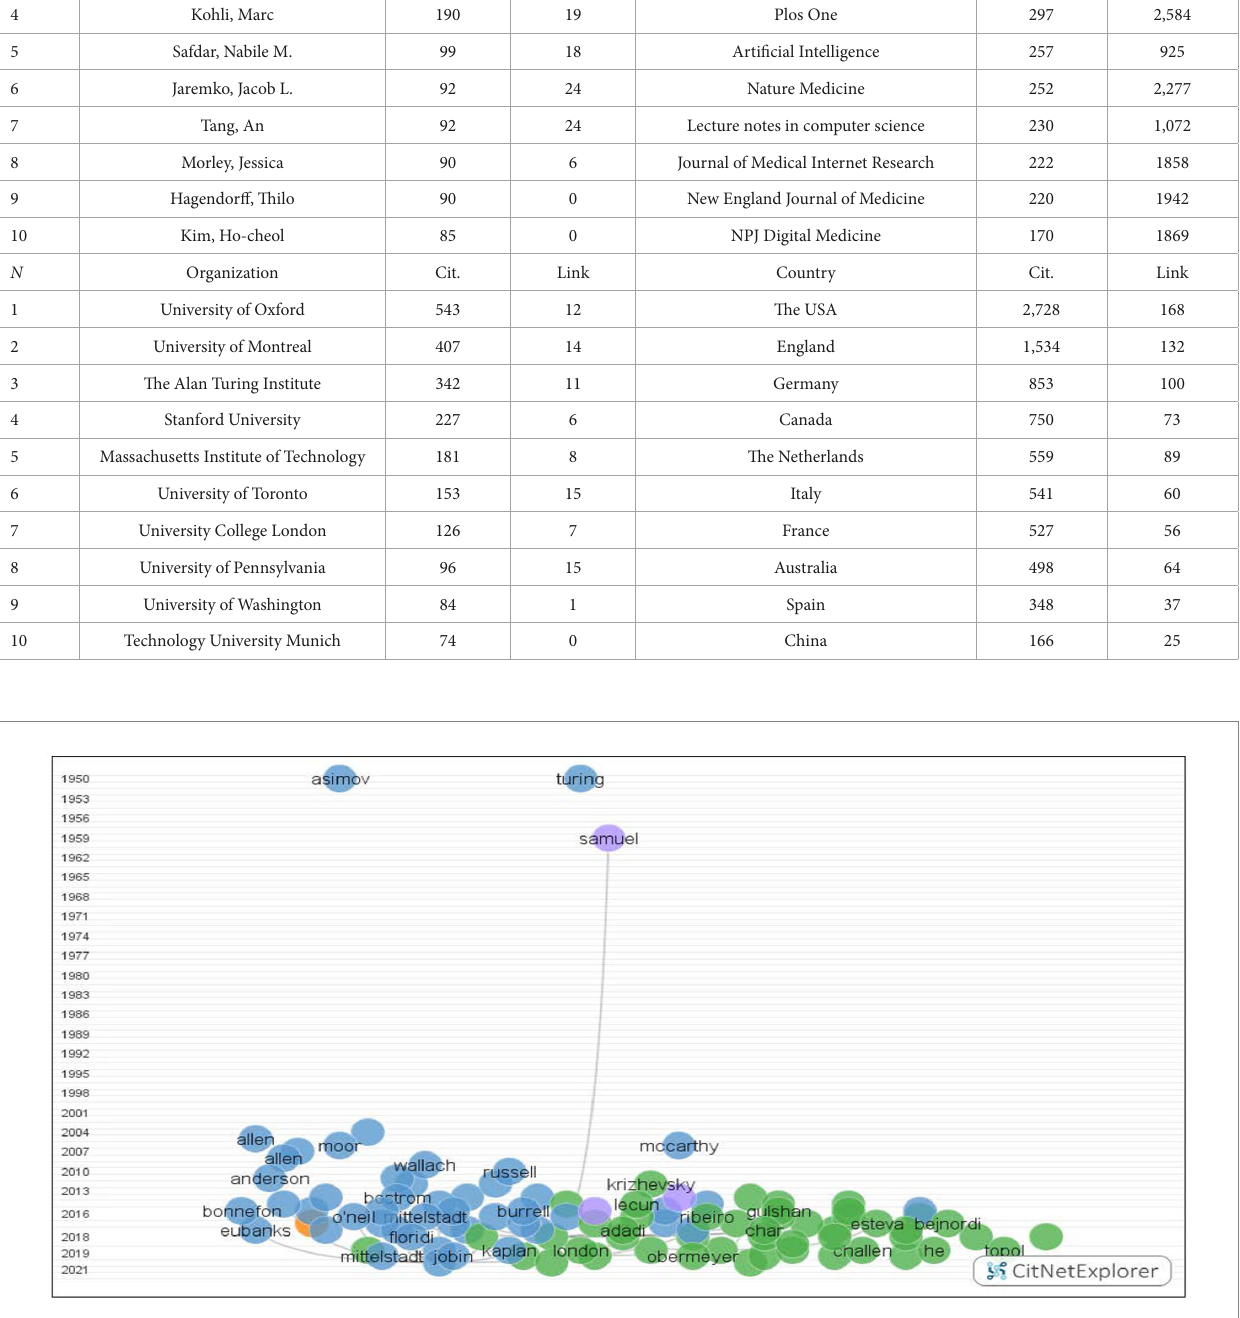
FIGURE 6 A clustering map based on citation networks.